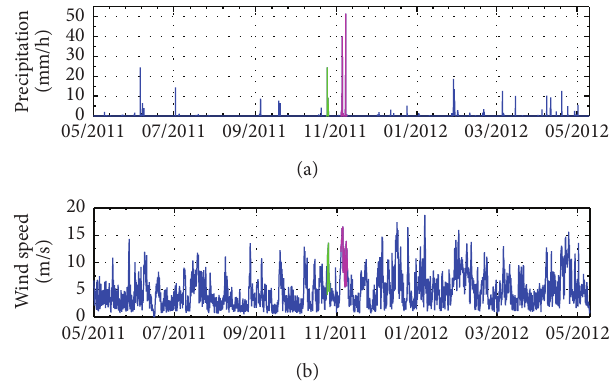
Figure 3: Times series of (a) hourly cumulative rainfall and (b) hourly averaged wind speed observations acquired by the rain gauge andthesonicanemometerduringtheexperiment.Datacorrespond- ing to the major events on the 25th of October and 5th–8th of November 2011 are highlighted.